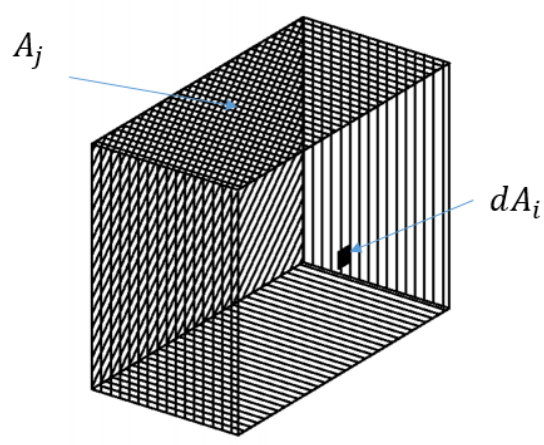
Figure 6. Calculation of the mean radiant temperature from ISO 7726